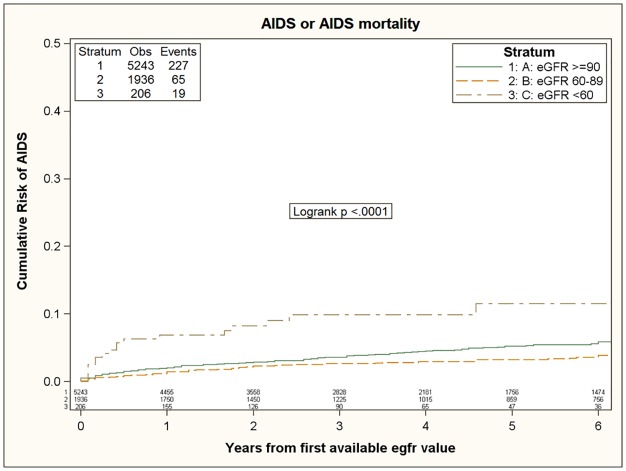
Risk of AIDS-events during follow-up according to basal eGFR.